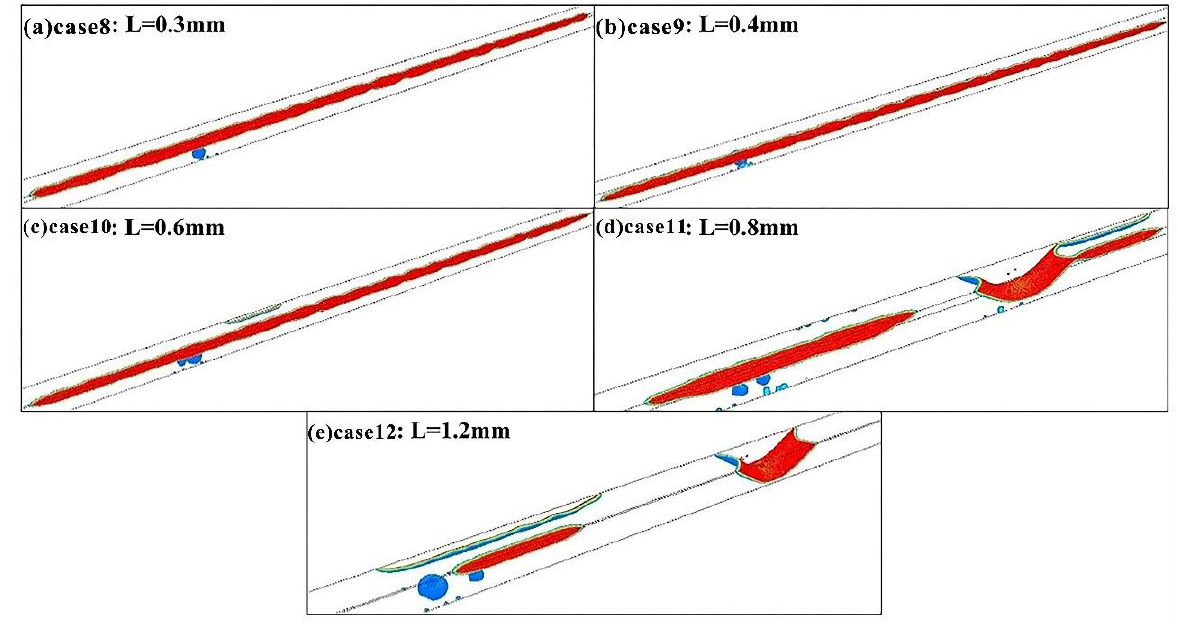
Figure 10. Effect of the pore distance on the liquid flow pattern in the channel. (( a ) case8: L = 0.3 mm, ( b ) case9: L = 0.4 mm, ( c ) case10: L = 0.6 mm, ( d ) case11: L = 0.8 mm, ( e ) case12: L = 1.2mm).